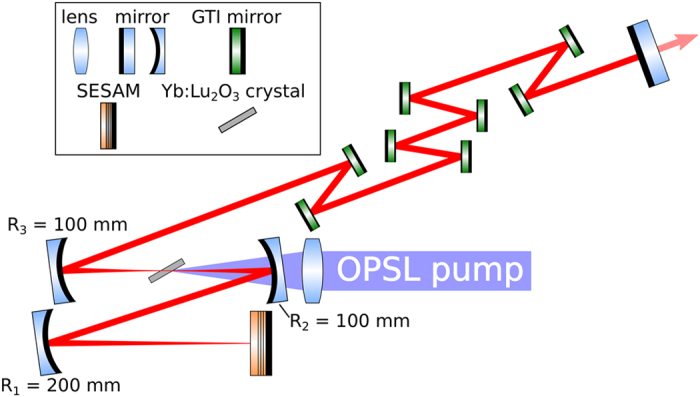
Experimental setup of the mode-locked OPSL pumped Yb:Lu2O3 oscillator.